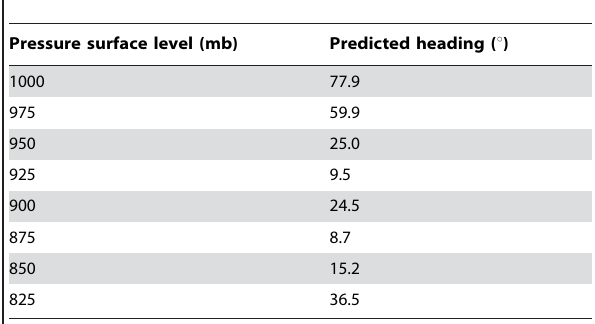
Table 1. Determining approximate flight